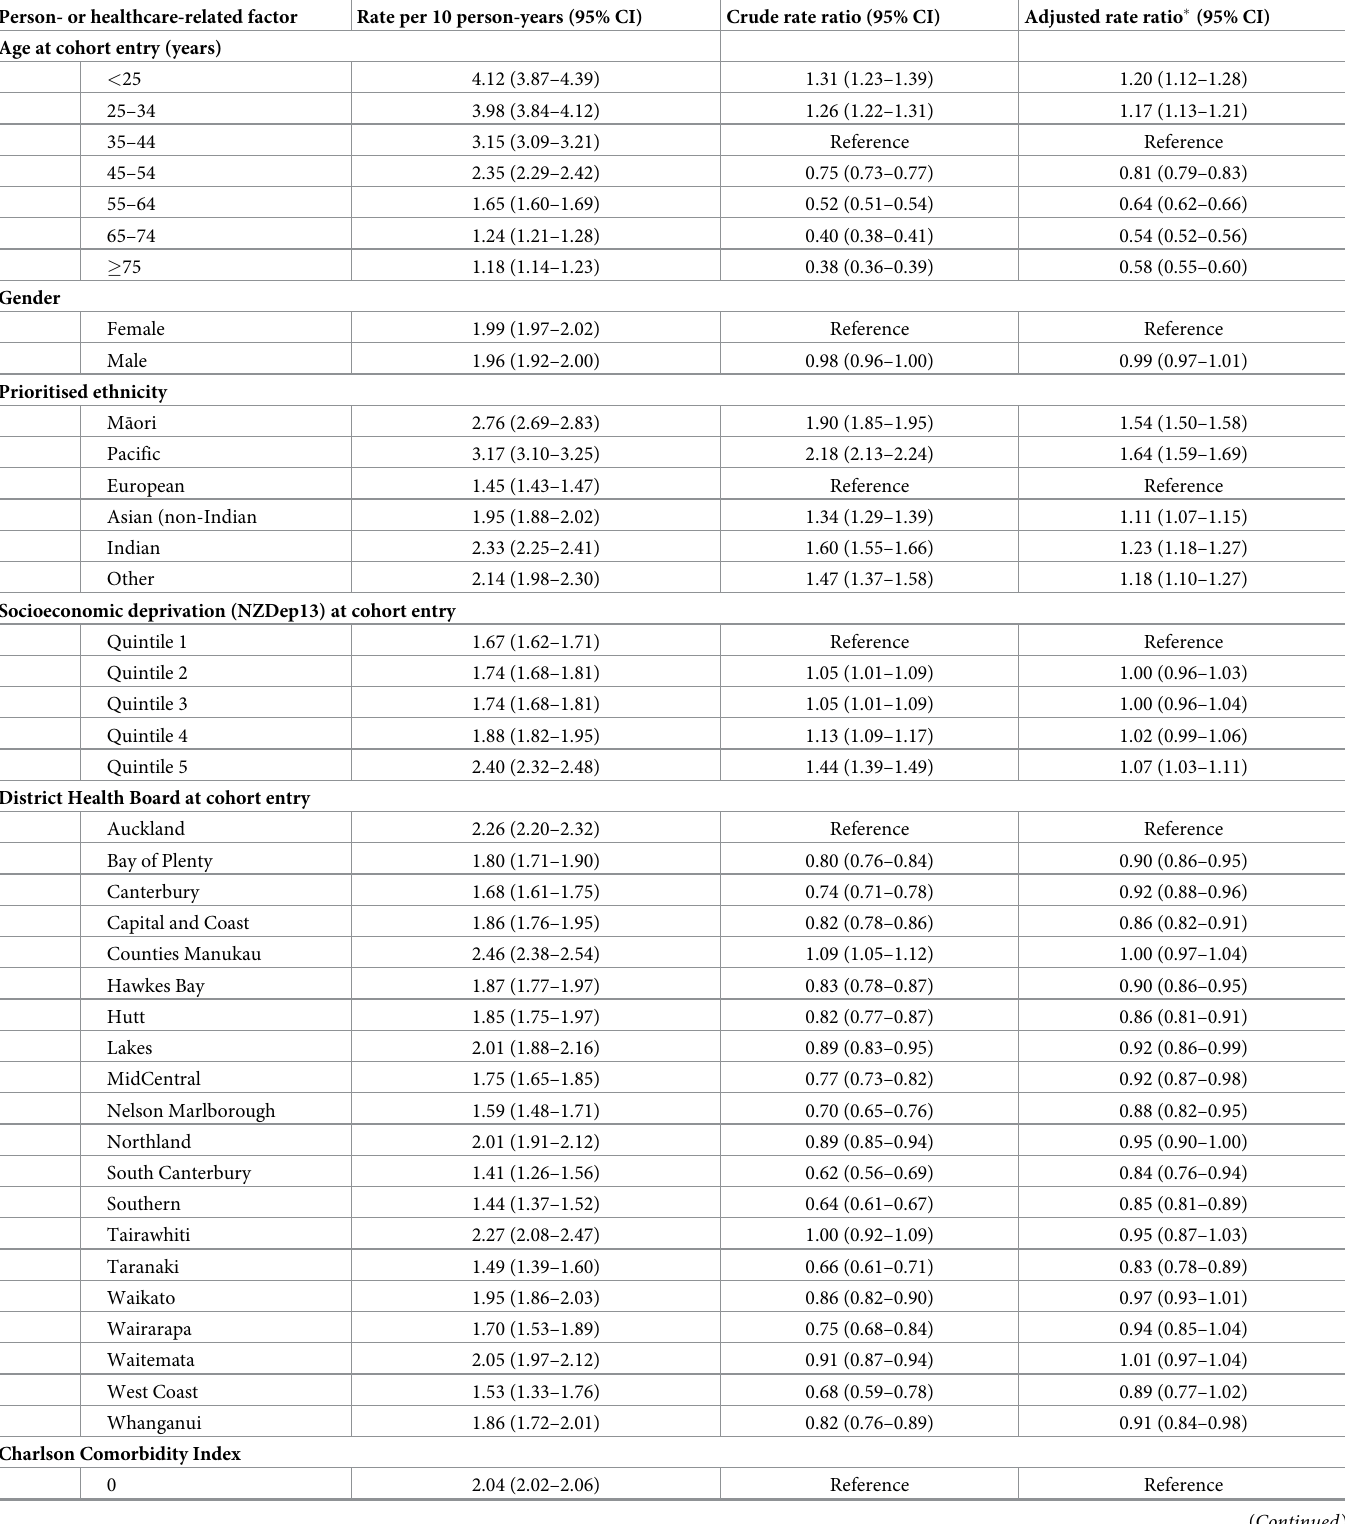
Table 3. Rate of discontinuation of metformin monotherapy and rate ratios by person- and healthcare-related factors at cohort